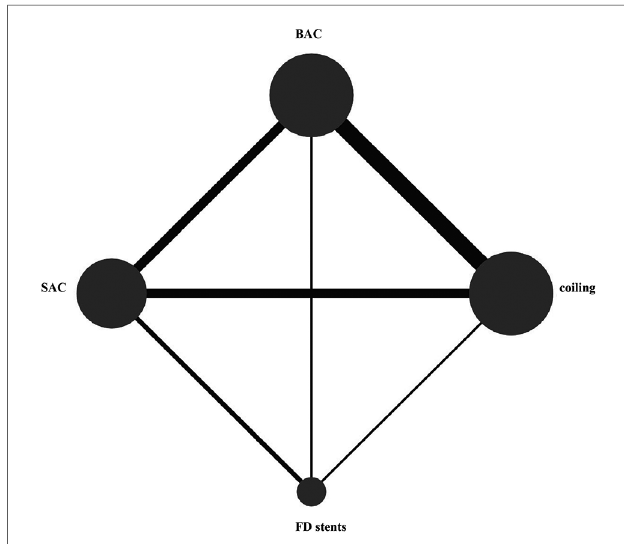
FIGURE 2 Network diagram of risks in the four endovascular treatments on DWI- positive lesions. BAC, balloon-assistant coiling; SAC, sent-assistant coiling; FD stents, fl ow-diverting stents.